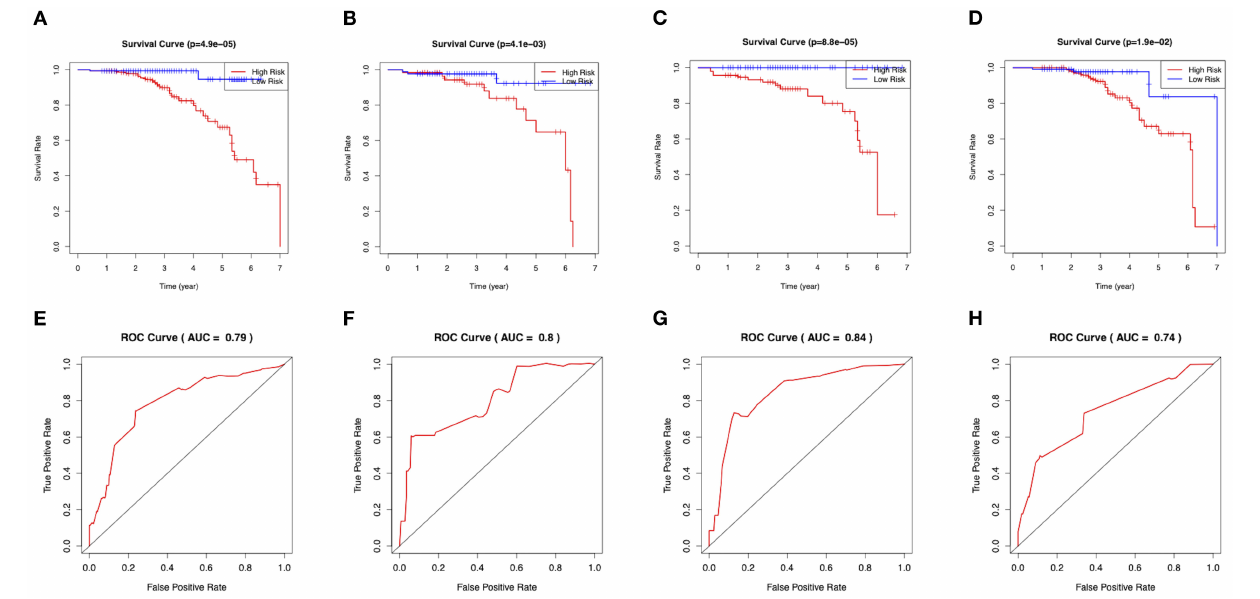
FIGURE 5 | Evaluation of the clinical performance of the nomogram. (A) The Kaplan-Meier plot of the predictive nomogram in the training set. (B) The Kaplan-Meier plot of the predictive nomogram in the test set. (C) The Kaplan-Meier plot of the predictive nomogram in the ischemic-type group. (D) The Kaplan-Meier plot of the predictive nomogram in the hemorrhagic-type MMD. (E) ROC curves for predictions of 3-year stroke-free survival in the training set. (F) ROC curves for predictions of 3-year stroke-free survival in the test set. (G) ROC curves for predictions of 3-year stroke-free survival in the ischemic-type group. (H) ROC curves for predictions of 3-year stroke-free survival in the hemorrhagic-type MMD.